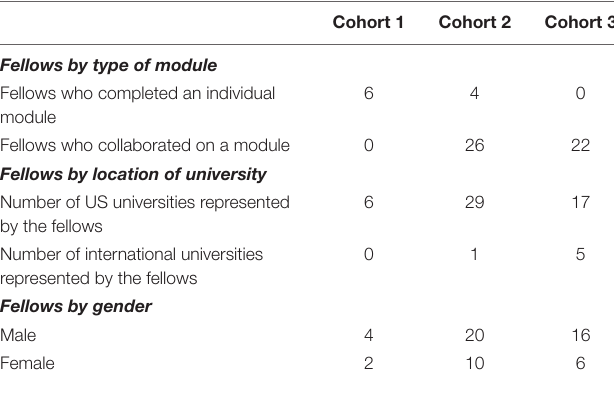
TABLE 1 | HydroLearn fellows by